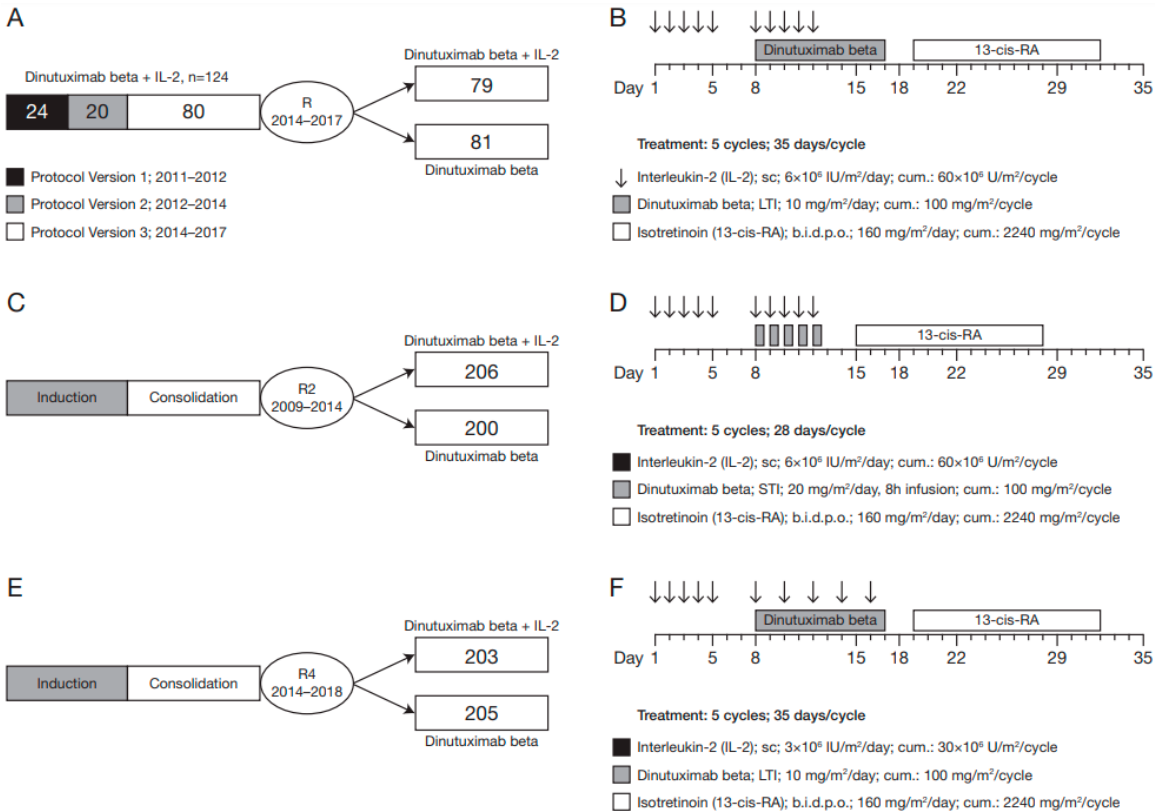
Figure 1. Schematic overview of study designs and treatment schedules in the LTI/SIOPEN study and the HR-NBL1/SIOPEN study. ( A , B ) Study design and treatment schedule of the LTI study. The study was initiated as a single-arm study of DB combined with scIL-2 in patients with relapsed/refractory high-risk neuroblastoma and amended in 2014 to include a randomizat design. Patients received either DB alone or DB combined with scIL-2. DB was administered as LTI (10 mg/m 2 continuous infusion over 10 days; total dose 100 mg/m 2 ). ( C , D ) Study design and treatment schedule of HR-NBL1-R2. Newly diagnosed patients with high-risk neuroblastoma were randomizat in the maintenance treatment phase to receive either DB alone or DB combined with scIL-2. DB was administered as STI (20 mg/m 2 /day on 5 consecutive days, 8 h infusions; total dose 100 mg/m 2 ). ( E , F ) Study design and treatment schedule of HR-NBL1-R4. The study was amended to evaluate LTI of DB and a dose-reduced relaxed schedule of scIL-2. B.i.d.p.o., twice-daily oral administration; DB, dinutuximab beta; LTI, long-term infusion; R, 4andomization; RA, retinoic acid; scIL-2, subcutane- ous interleukin-2; STI, short-term infusion.